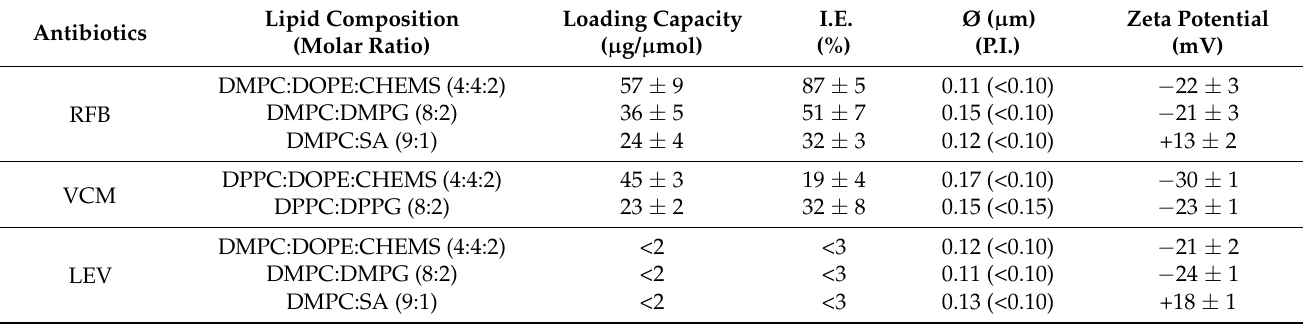
Table 2. Physicochemical properties of antibiotics-loaded liposomes: influence of the antibiotic and lipid composition on incorporation